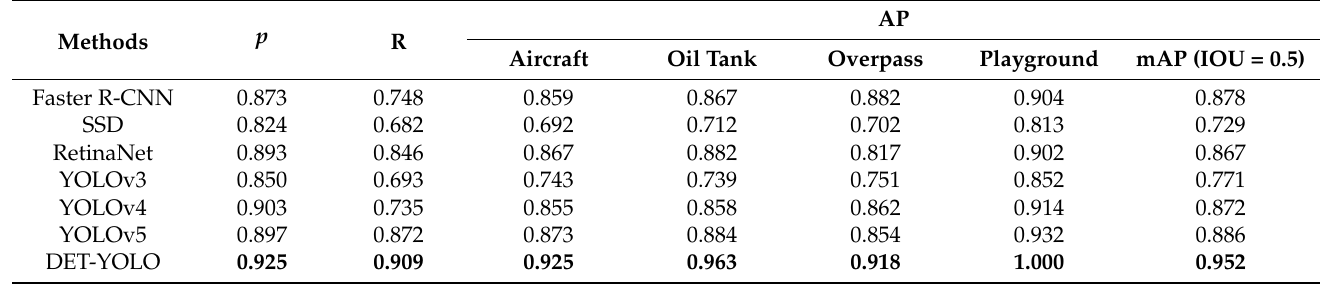
* Bold indicates the best result in the current table. Tables 4–6 are the same. Table 4. Comparison of the performances of various models on the RSOD dataset.